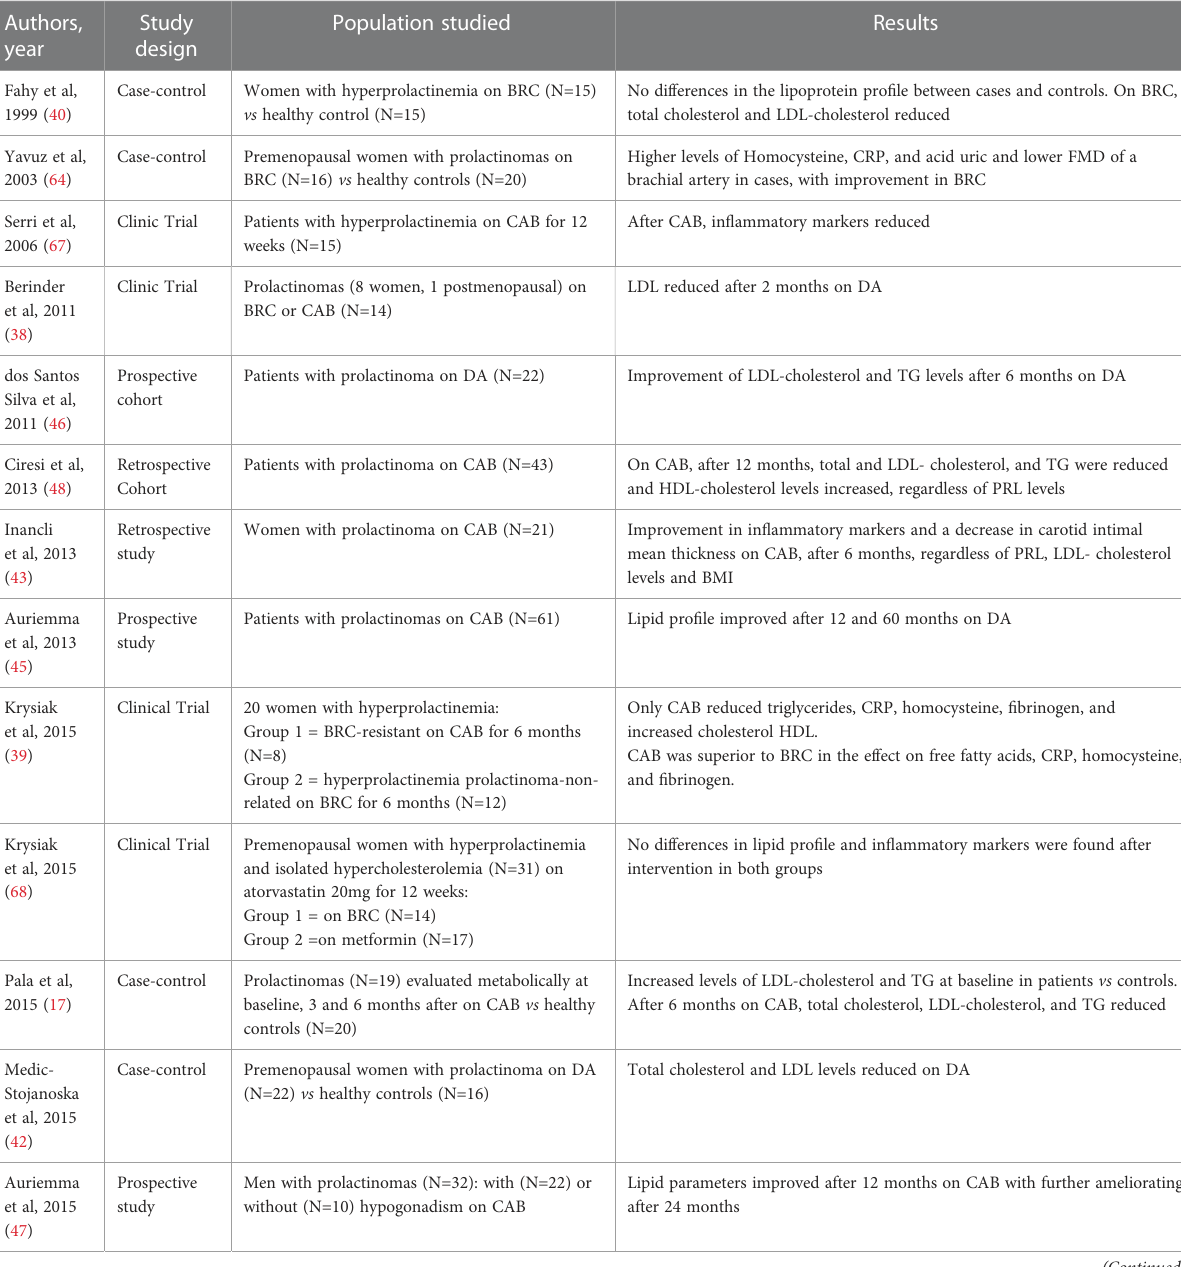
TABLE 2 Studies with patients with hyperprolactinemia/prolactinoma on DA